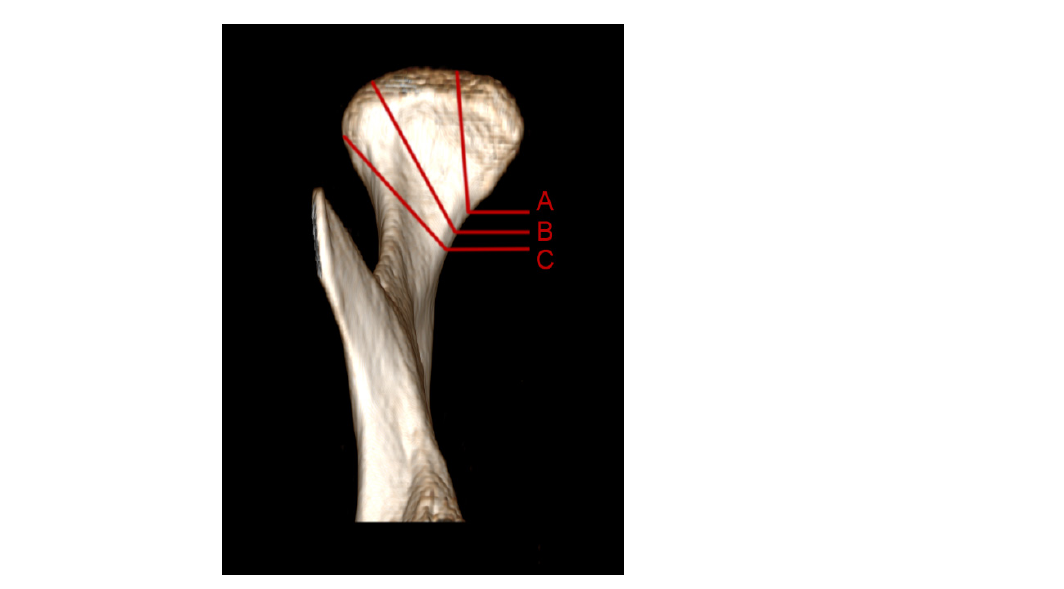
Figure 2. Illustration of mandibular head classification based on the right mandibular condylar process [19]. A—fracture of the medial pole of the mandibular head. B—the fracture line runs through the lateral pole of the mandibular head or near its medial portion. C—the fracture line runs just below the lateral pole of the mandibular head.